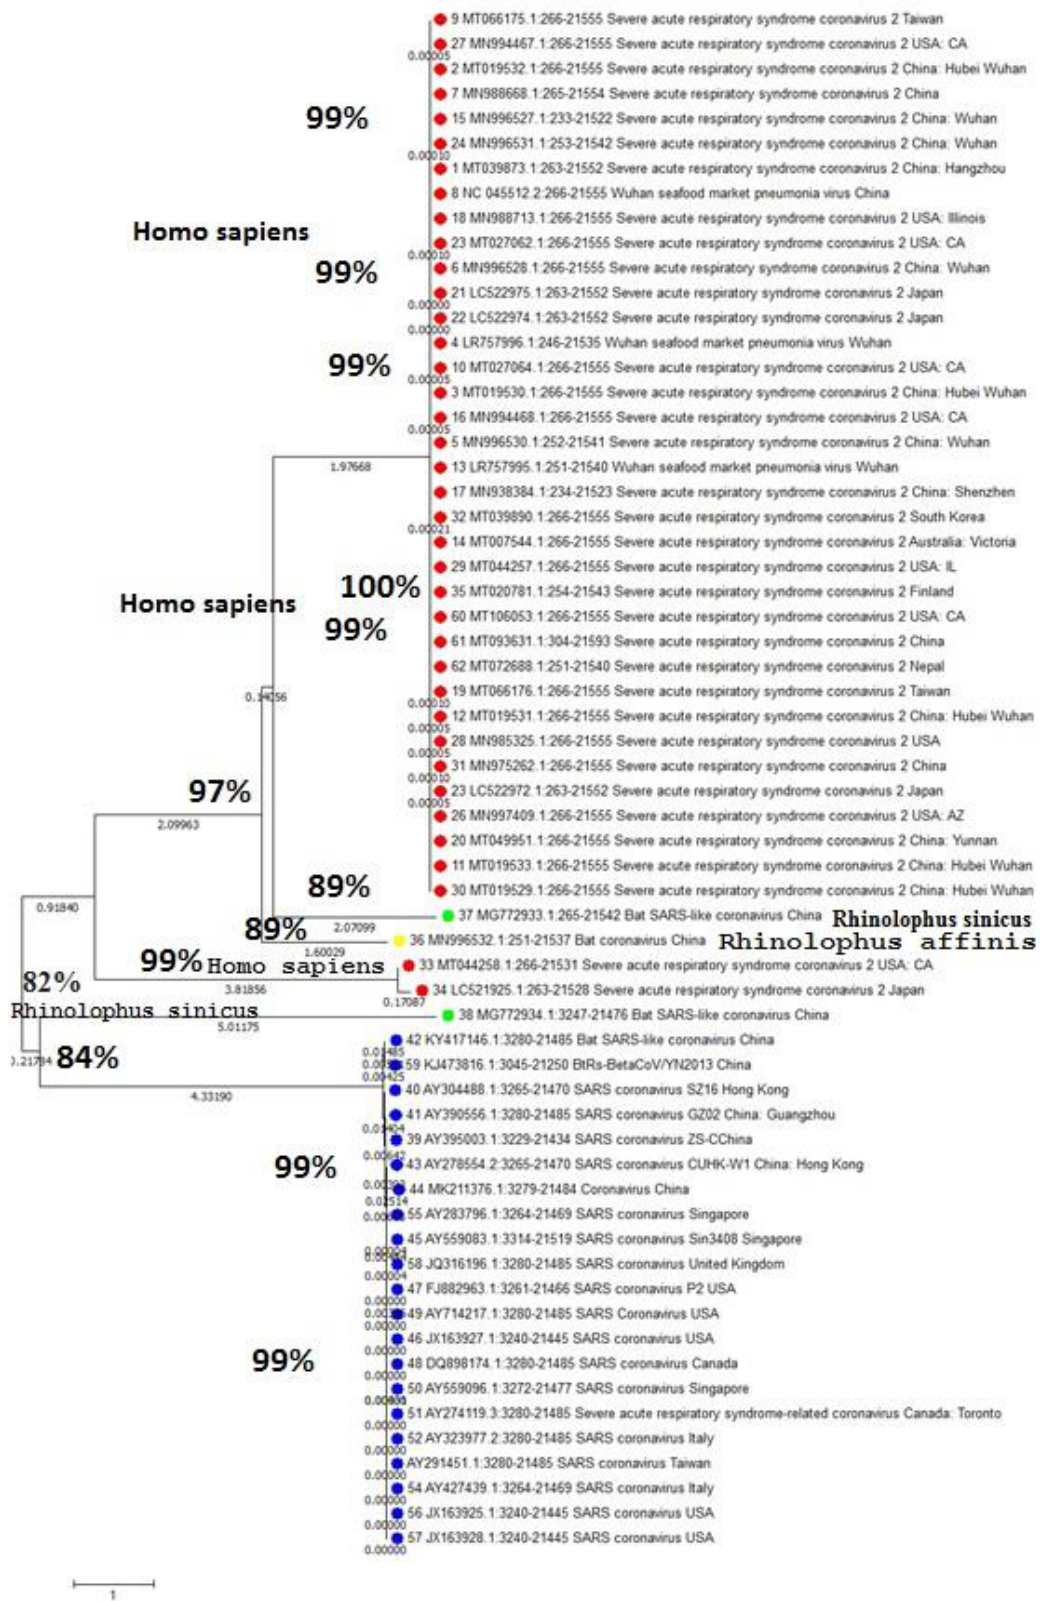
Figure 1. Neighbor-joining tree of